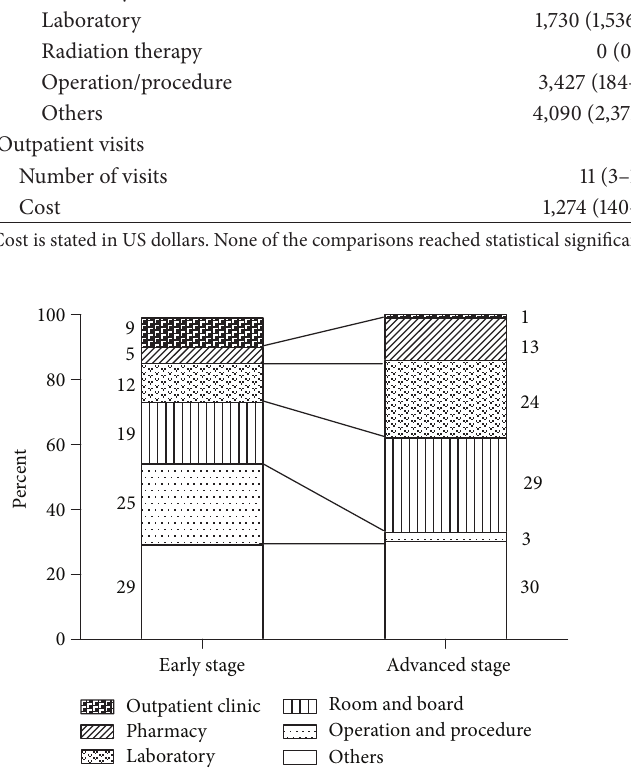
Figure 2: Categories of cost for lung cancer treatment according to the stage. The contribution of each category to total cost is represented as percentage